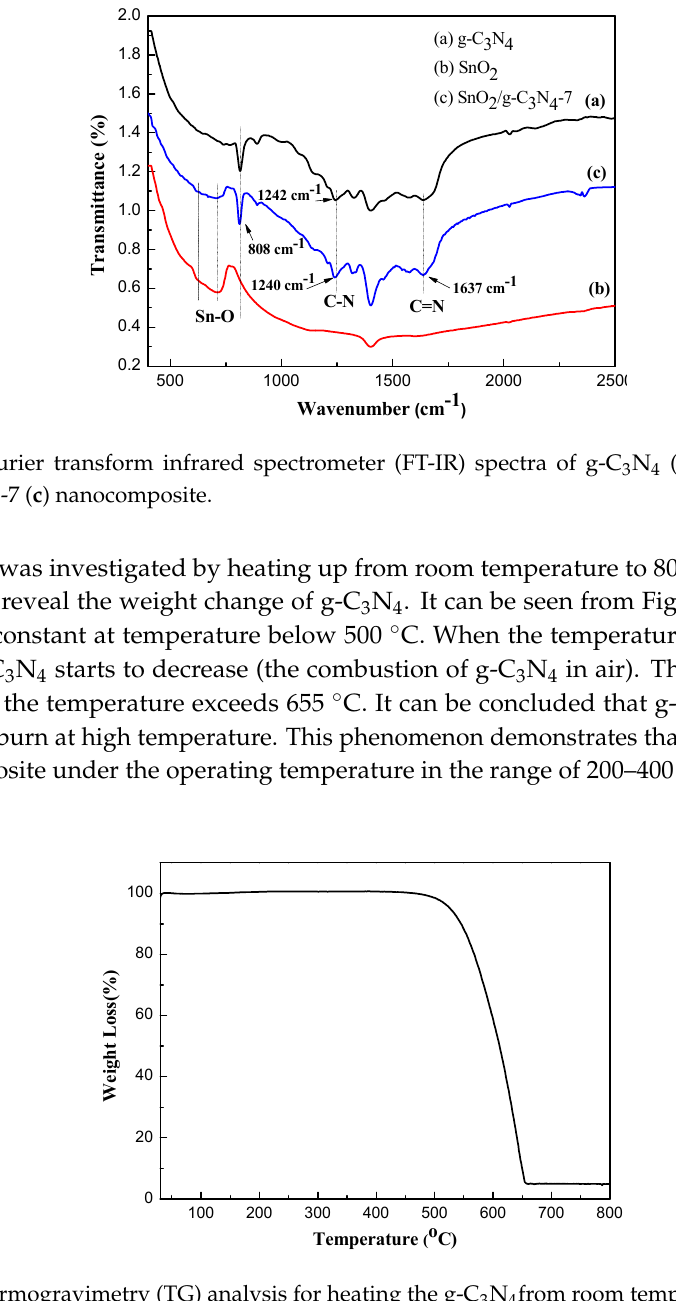
◦ 3 N 4 from room temperature to 800